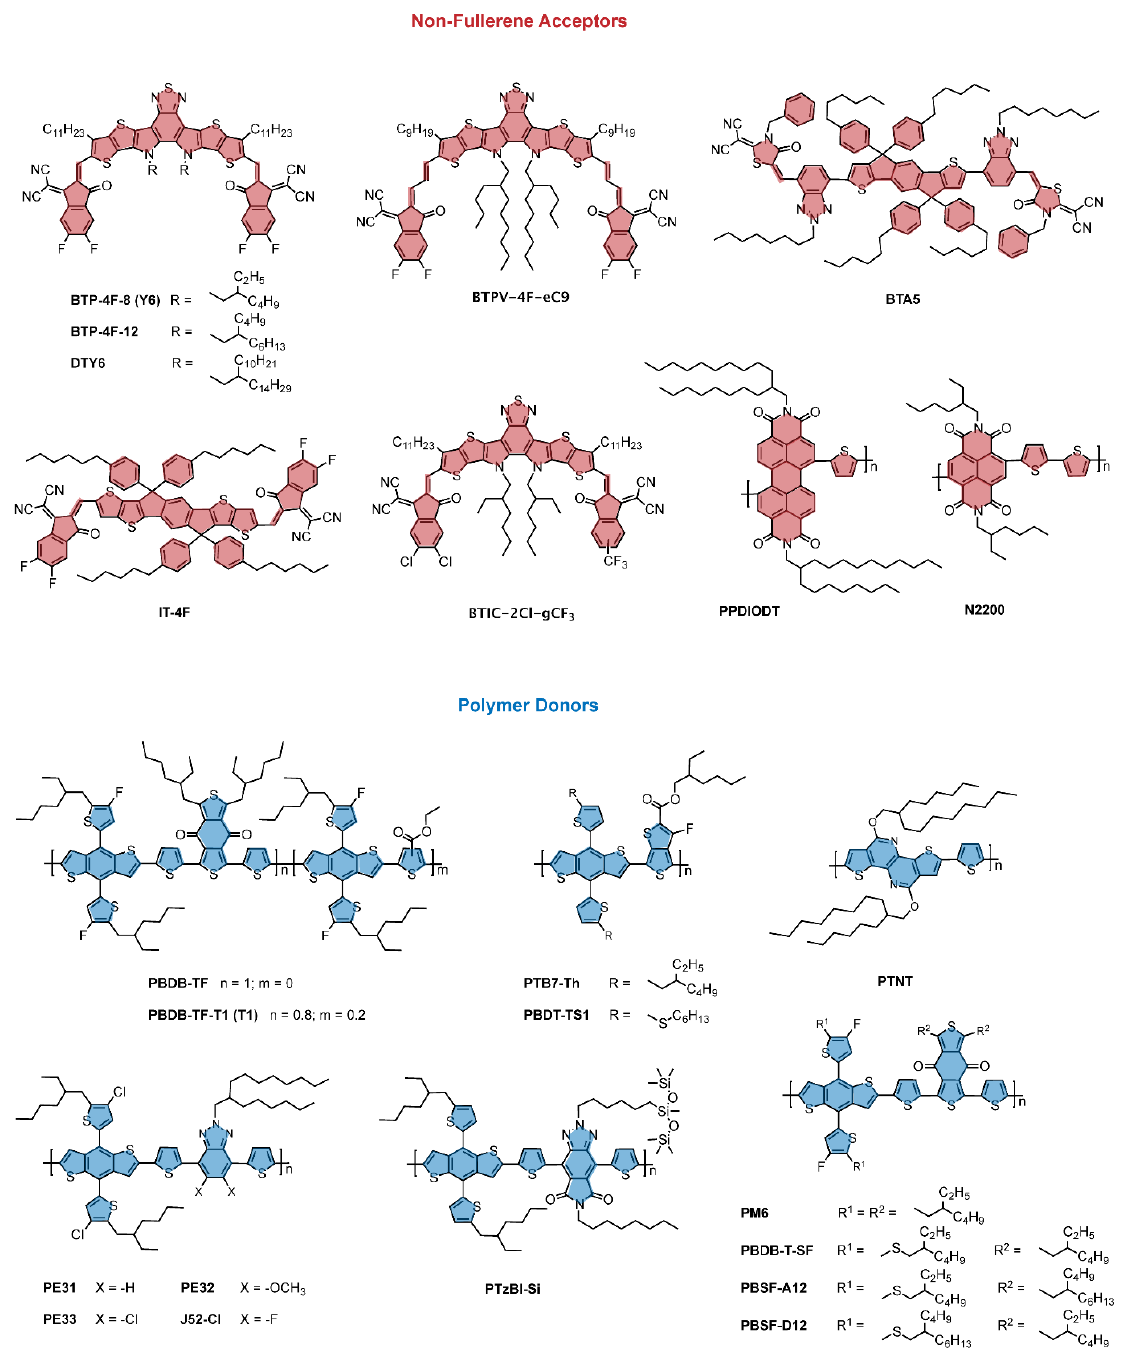
Figure 5. Selected representative examples of NFAs and polymer donors used in BHJ solar cells processed from non- halogenated solvents.